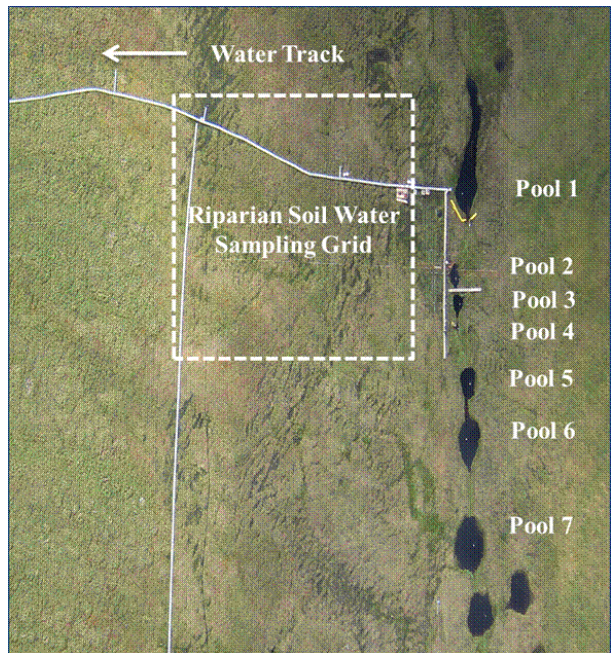
Figure 1. Study area showing the 120m reach of Imnavait Creek containing seven consecutive pools, and the locations of soil water collection (riparian zone and water track; only the bottom portion of the water track is shown in this image). Also visible in this areal im- age as white solid lines are boardwalks installed to access sampling